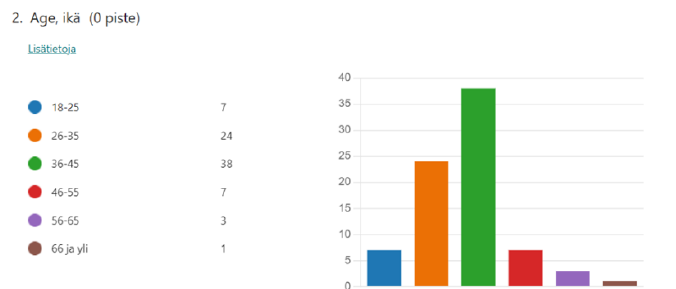
Figure 2. Age division of the respondents. Source: (Authors’